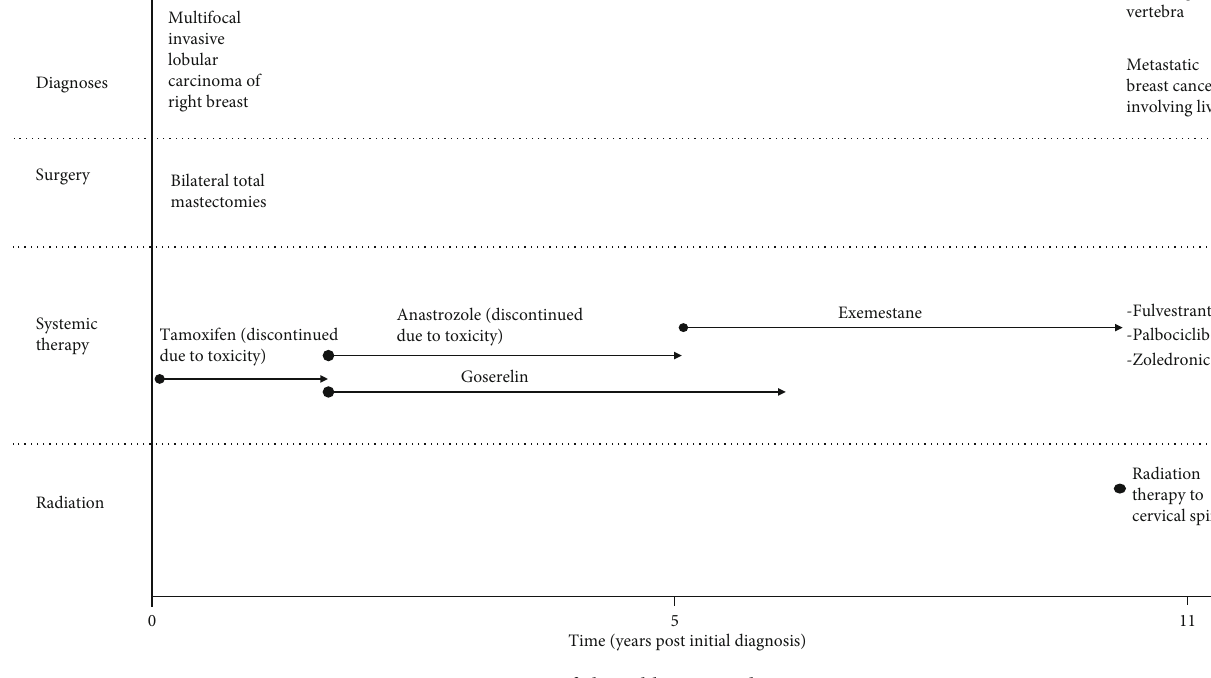
Figure 1: Overview of clinical history and